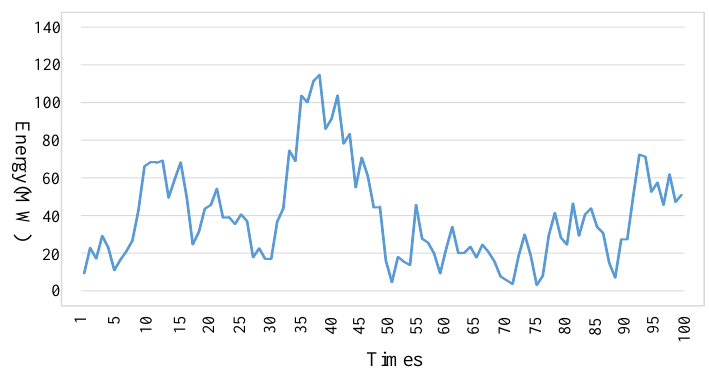
Figure 17. Energy storage results.